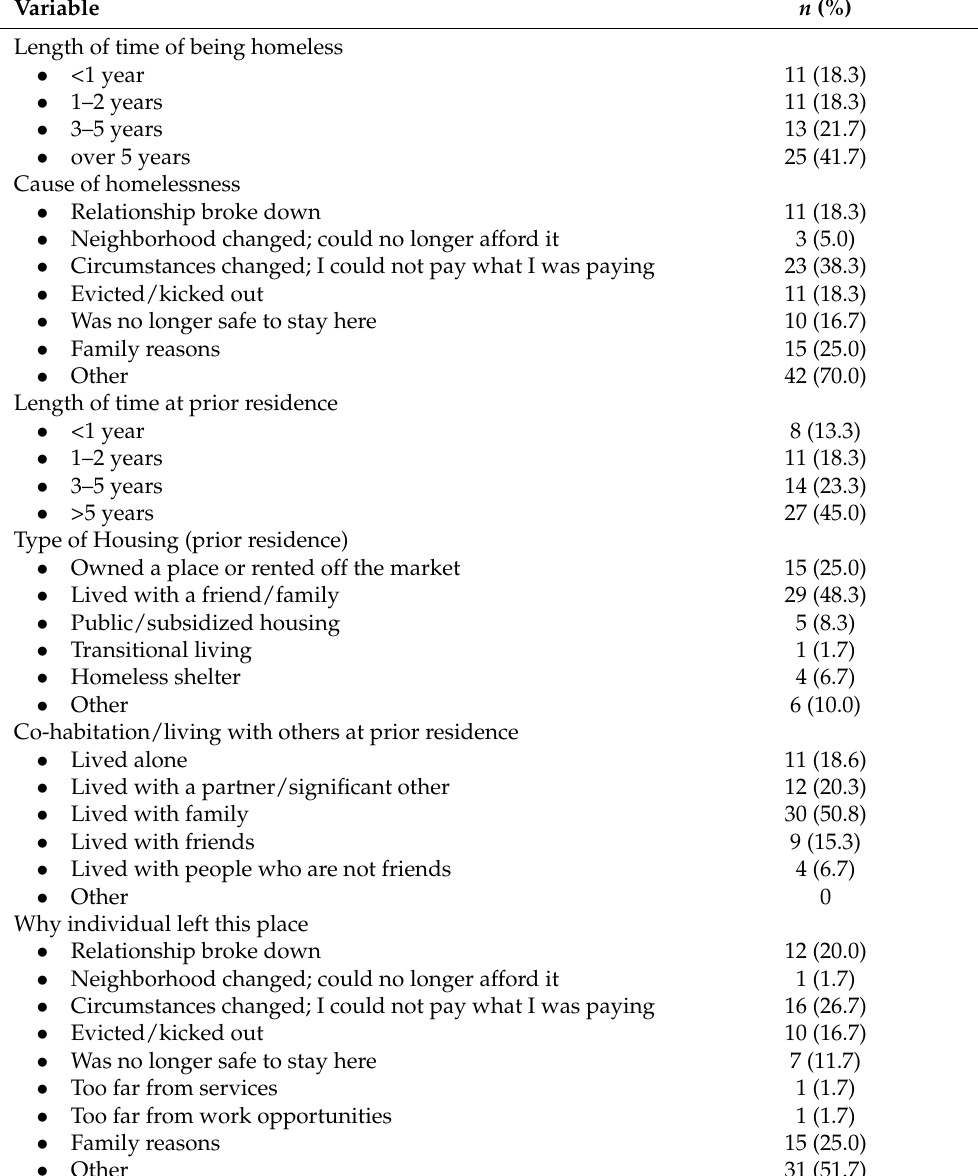
Table 3. Description of housing instability among unhoused participants ( n =